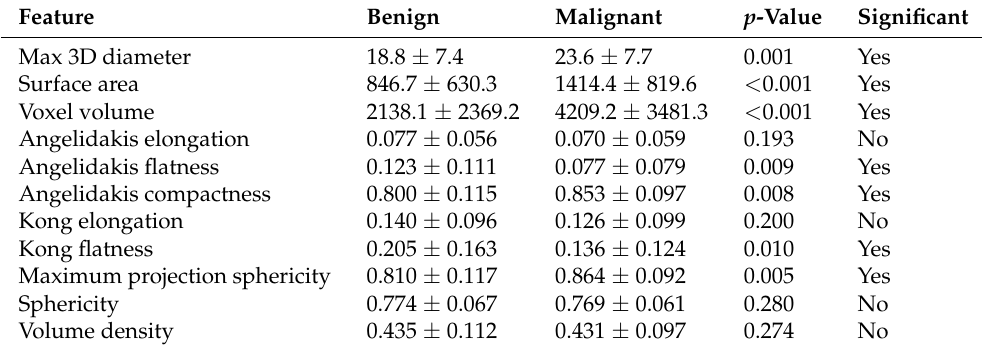
Table 4. Results of the univariate analysis on the SSR-1 dataset. Units of measure: maximum 3D diameter [mm], surface area [mm 2 ], and volume [mm 3 ]; all other features are in dimensionless units (range 0–1).